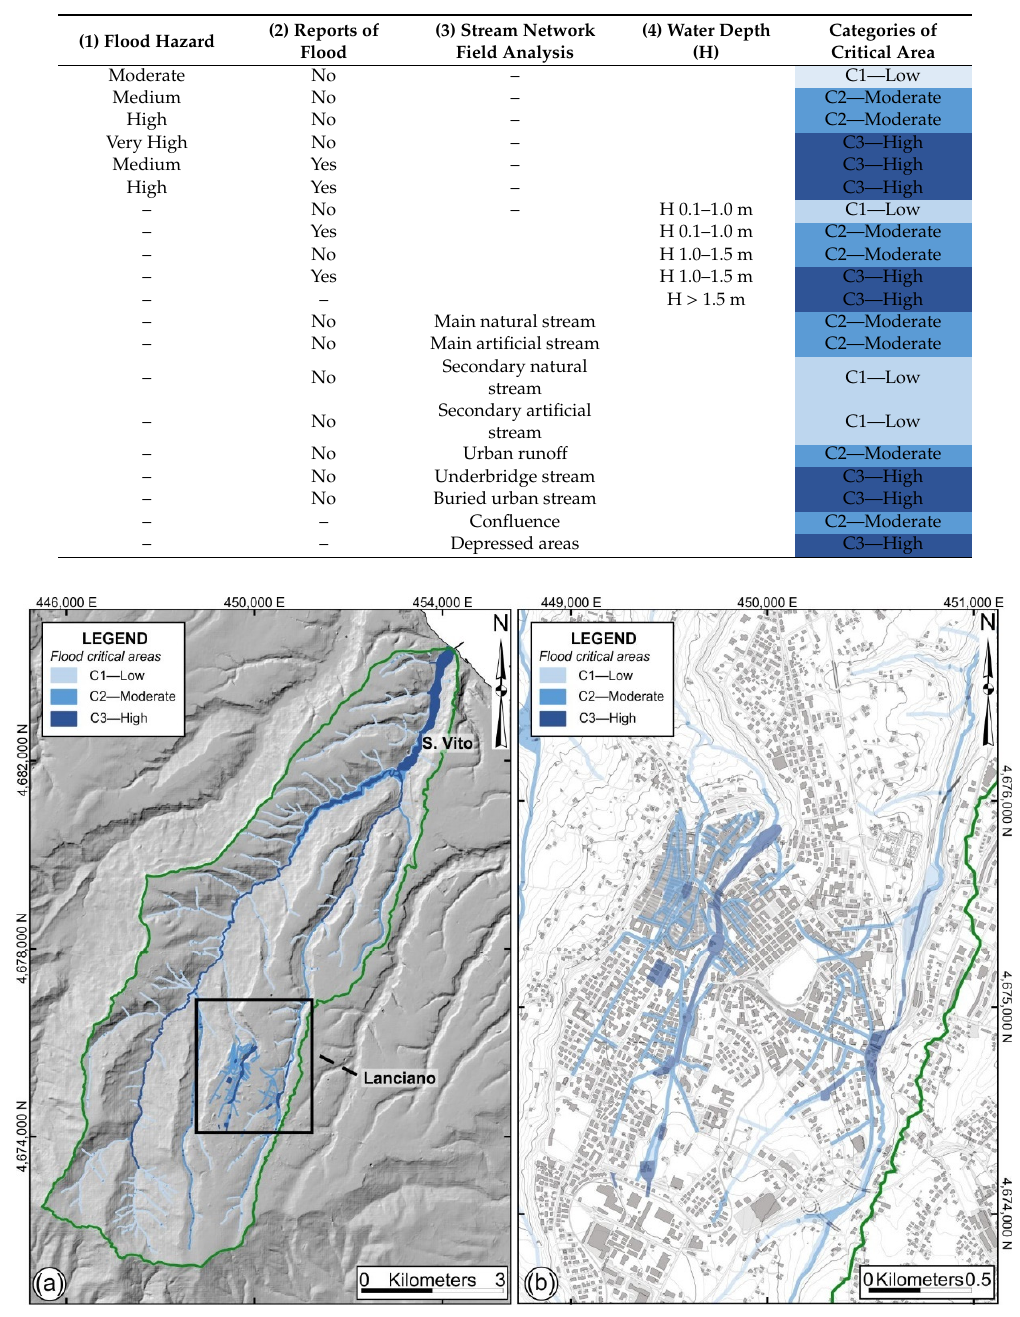
Figure 16. Flood critical areas: ( a ) for the Feltrino Stream basin; ( b ) for the urban area of Lanciano). Green line: Feltrino Stream basin.